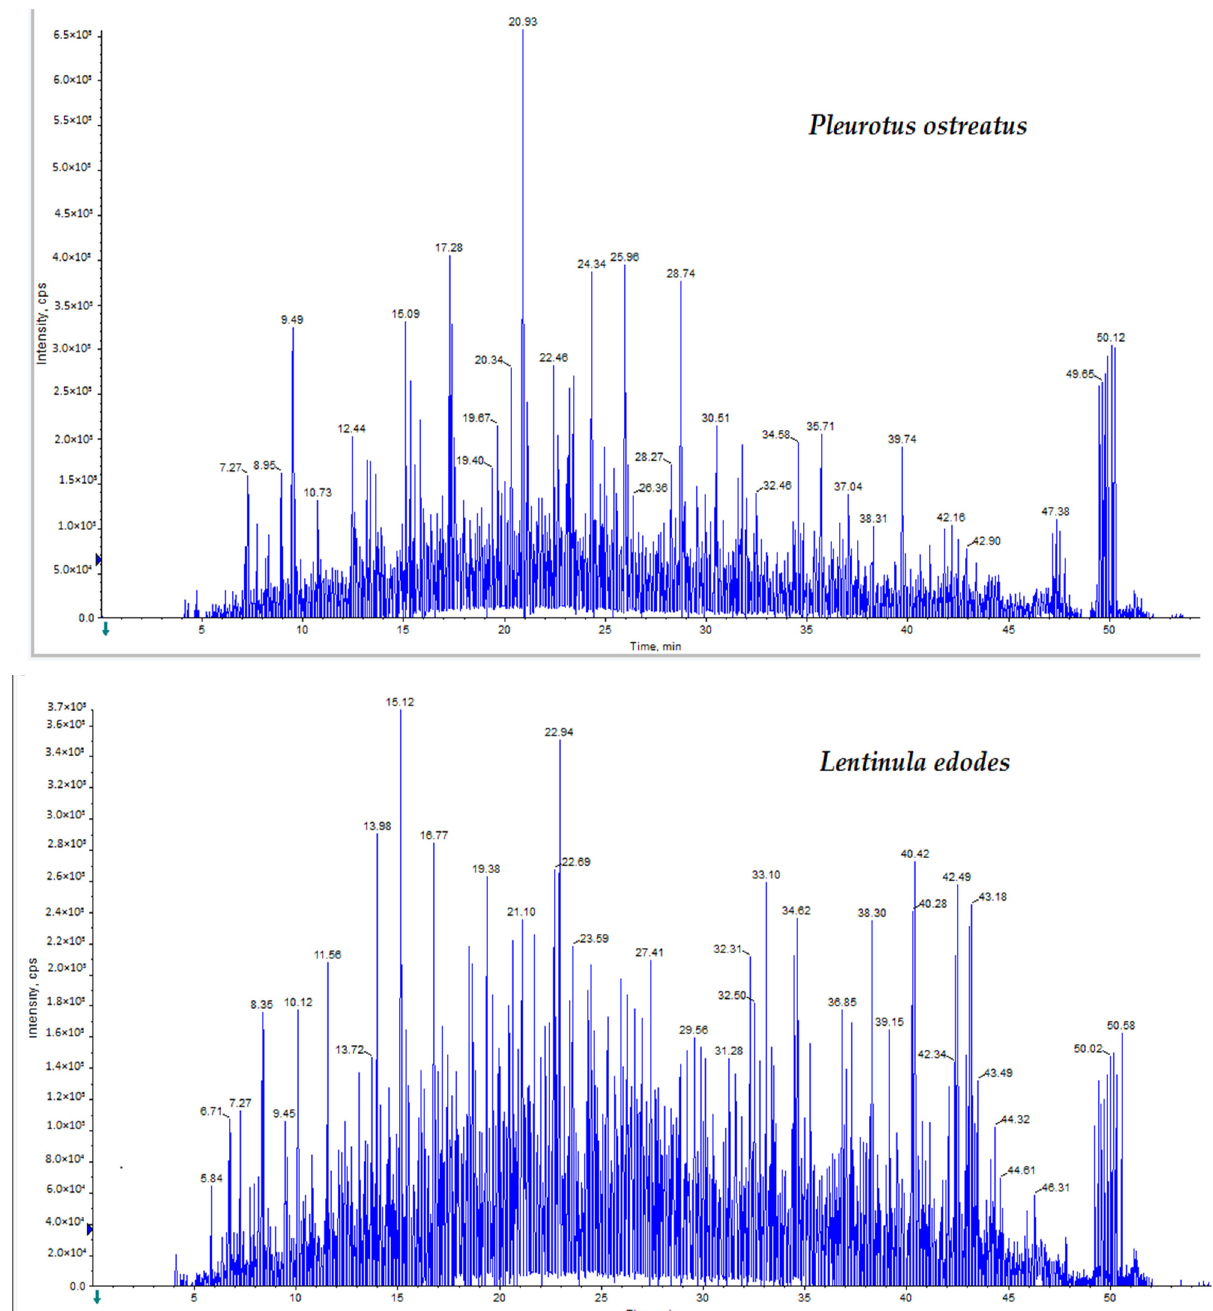
Figure 1. LC-Triple TOF-MS spectra showing the ion peaks of the mushroom proteins using Analyst (Sciex software).